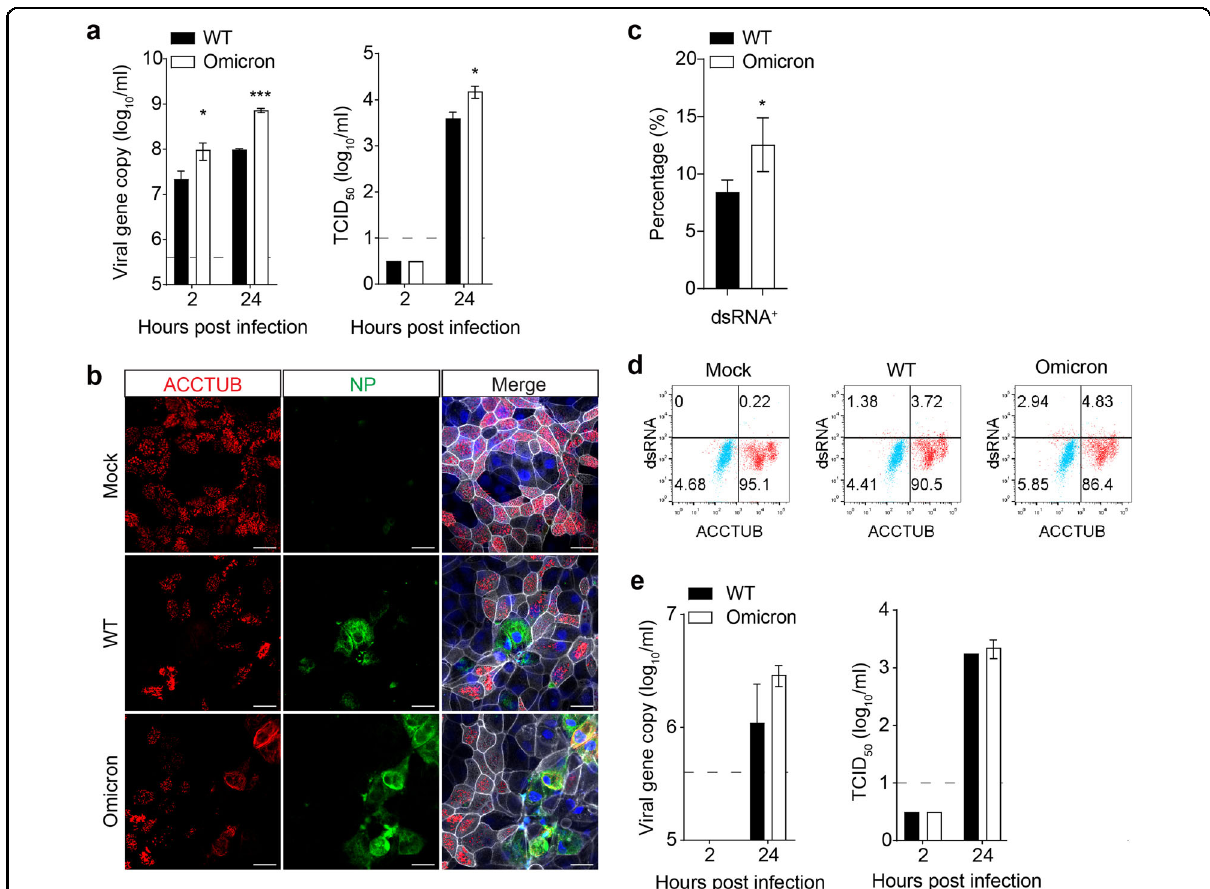
Fig. 6 Higher fi tness and infectivity of the Omicron variant compared to a WT strain in 2D AwO. a At the indicated hours after inoculation with WT or the Omicron variant (MOI = 0.1), culture media were harvested from the apical chambers of the 2D airway organoids and applied to viral load detection and viral titration by TCID 50 assay. Data show means ± SD of a representative experiment, n = 3. Two-tailed unpaired Student ’ s t -test. b At 24 hpi (MOI = 2), infected AwOs or mock-infected organoids were co-stained with α -NP (green) and α -ACCTUB (red). Scale bar, 20 µm. c At 24 hpi of the Omicron variant and WT virus (MOI = 10), 2D AwOs were dissociated and applied to fl ow cytometry to detect dsRNA + cells. Data represent means ± SD of a representative experiment, n = 4. Two-tailed unpaired Student ’ s t -test. d Representative fl ow cytometry analysis dot plots of mock or infected AwOs (MOI = 1) co-stained with α -dsRNA (PE-Texas red) and α -ACCTUB (FITC). e At the indicated hours after inoculation with WT or the Omicron variant (MOI = 1), culture media were harvested from the AlvO and applied to viral load detection and viral titration by TCID 50 assay. Data show means ± SD of a representative experiment, n = 3. See also Supplementary Fig.